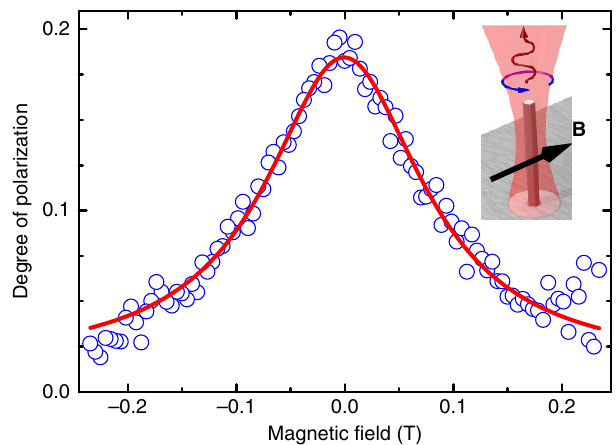
Figure 3 | Hanle effect measurement for a single WZ GaAs NW. The degree of polarization of the WZ free exciton emission decreases as a function of the transverse magnetic field. The continuous red line is a Lorentzian fit to the data using equation (1). The schematic measurement configuration is